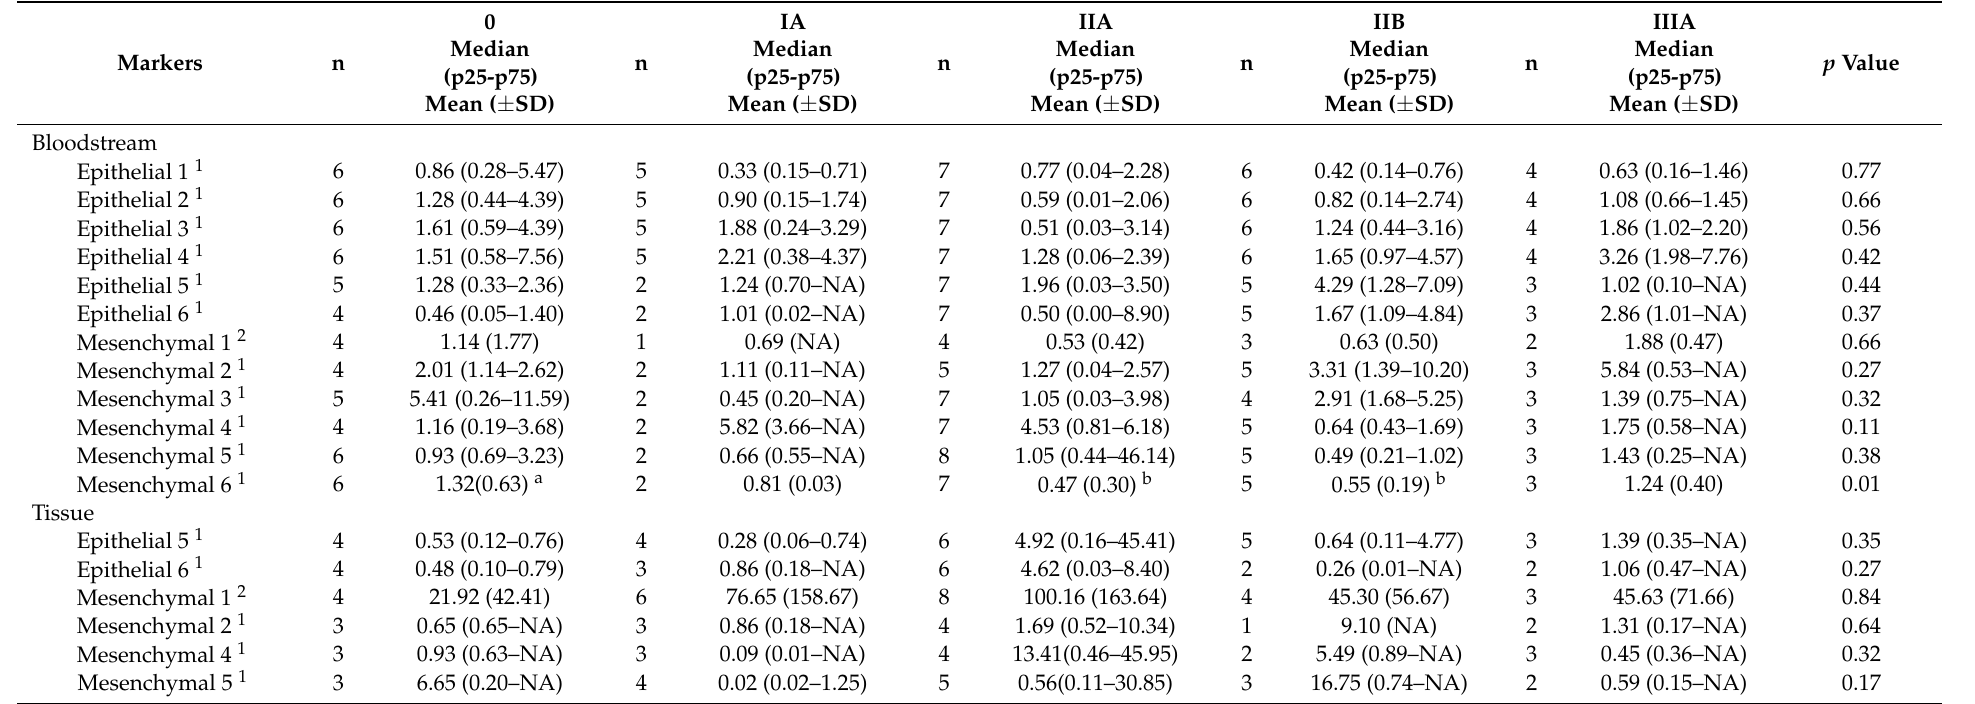
Table 4. Comparison of means between transcriptional levels of target genes and pathological